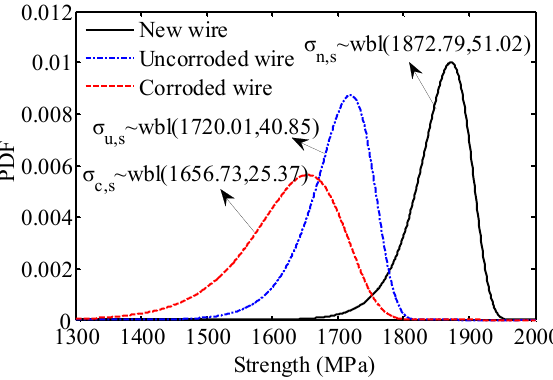
Figure 1. Comparison of the PDFs of the short wire strength accounting for fatigue damage and corrosion.